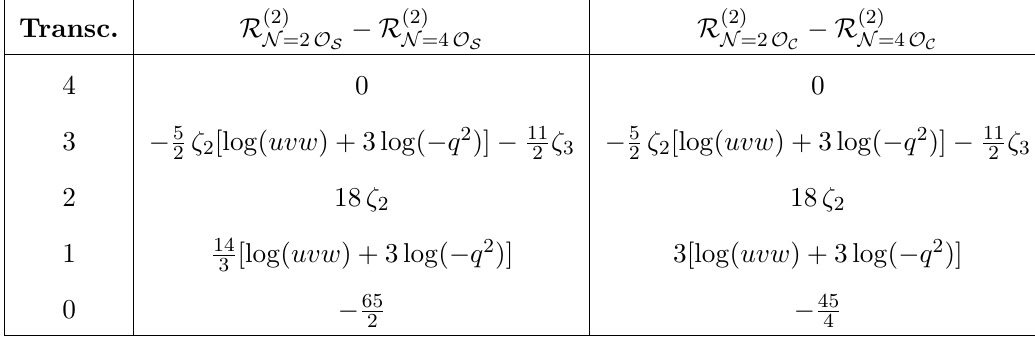
Table 4 . Di(cid:11)erence between two-loop Catani remainders of operators O S and O C when calculated in N =4 and N =2 SYM, split by transcendentality